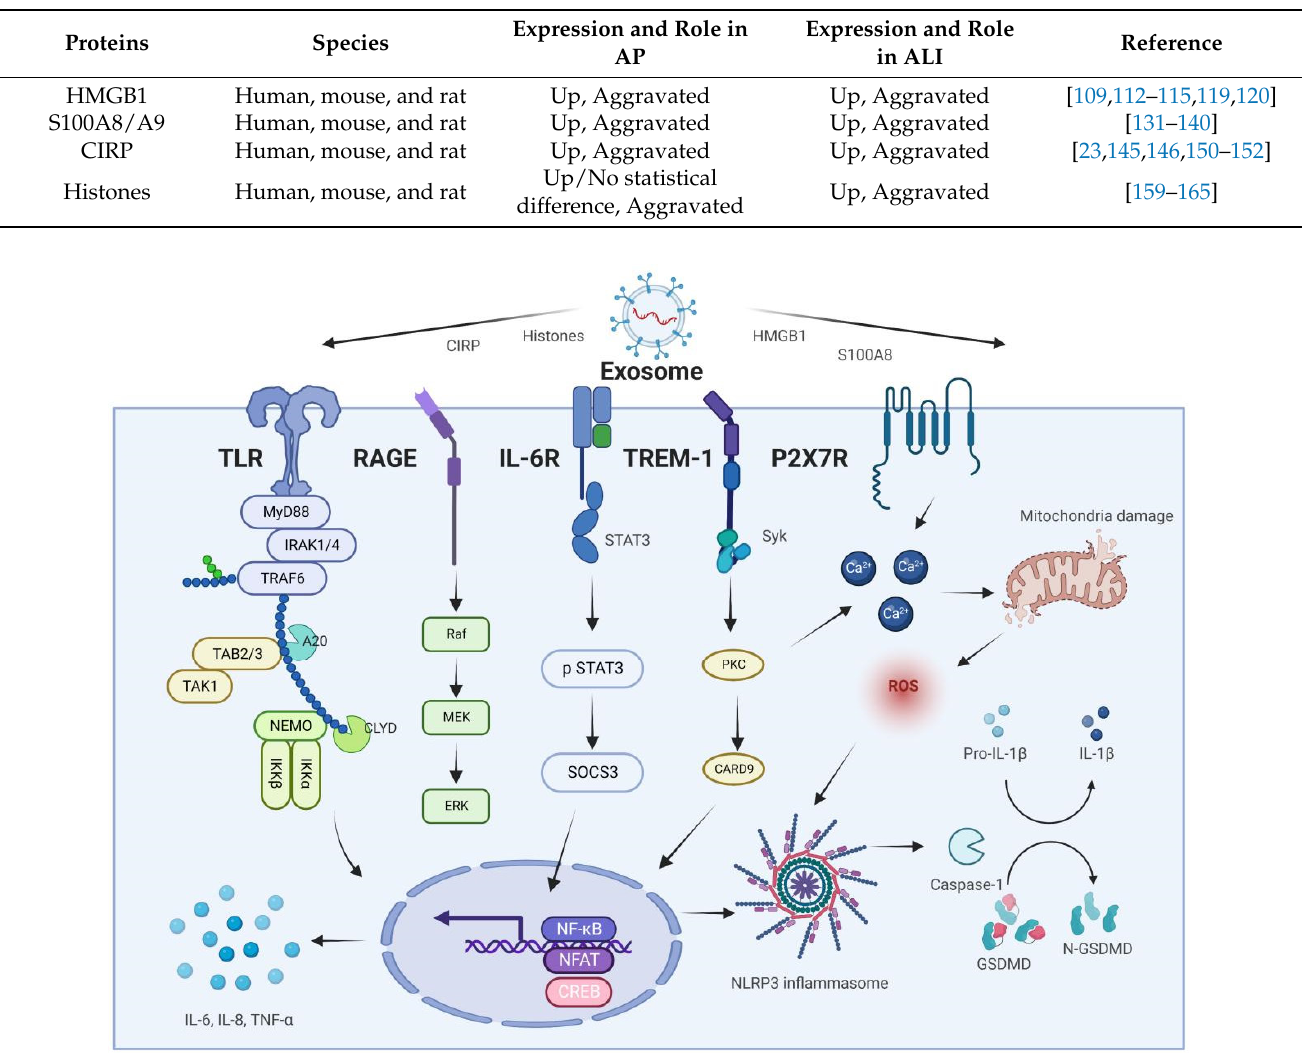
Table 2. Exosome-proteins in AP and ALI.